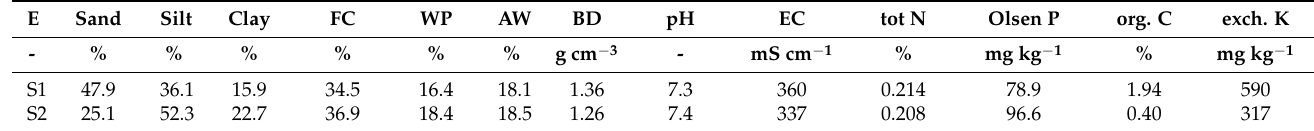
Abbreviations are as follows: E = environment; SRAD = solar radiation. Table 2. Soil physical and chemical characteristics in the investigated fields.